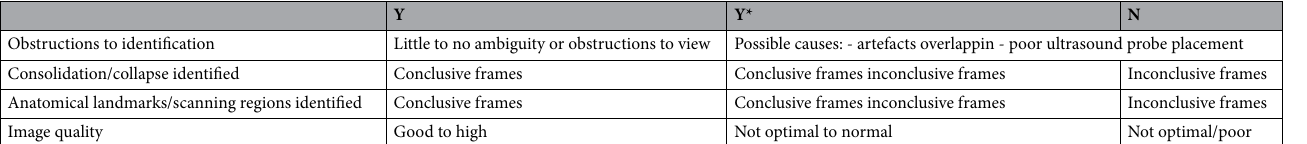
Table 2. The clinical criteria used to score LUS videos that have been evaluated by the algorithm beforehand. The labelling system determines a certain confidence of an experienced sonographer to identify the overall rating of a video based on the corresponding consolidation/collapse imaging pattern per frame using anatomical markers, image quality, and other possible obstructions for appropriate identification.